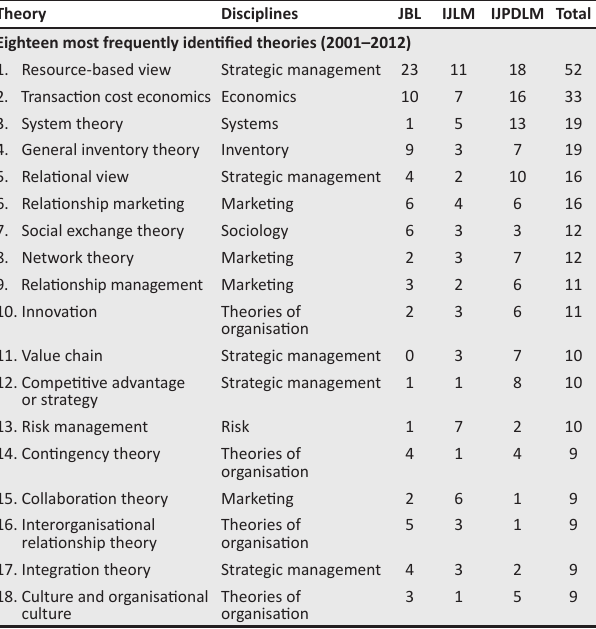
TABLE 6: Breakdown of theoretical categories by logistics and supply chain management (2004–2009).